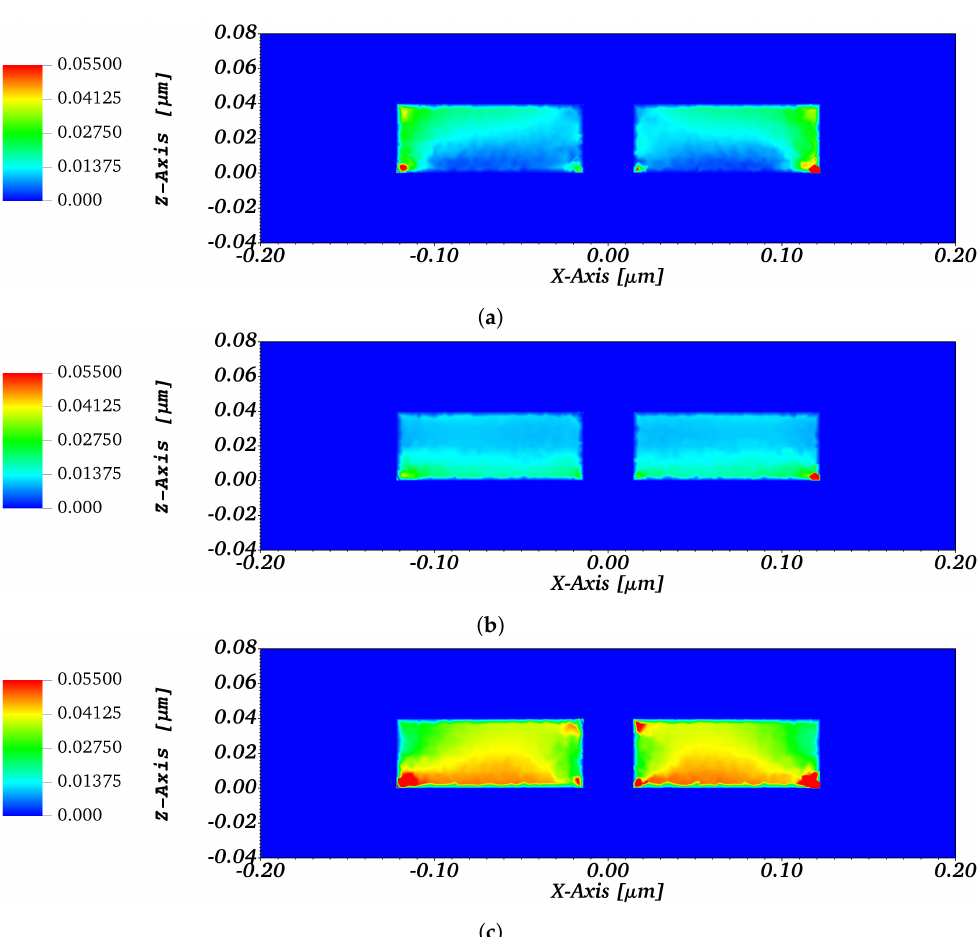
Figure 16. Side view ( y = 0-cut) of the electric current density on the gold nanoparticles: ( a ) 664.8 nm (substrate mode #1), ( b ) 661.3 nm (antenna mode #3), and ( c ) 632.2 nm (antenna mode #4) wave- lengths.